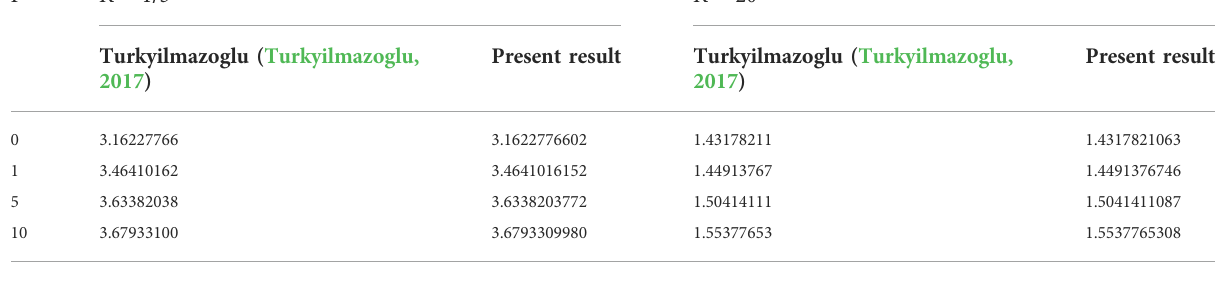
TABLE 1 Comparison of the present work with the published work (Turkyilmazoglu, 2017) on − θ 9 ( 0 ) . Γ